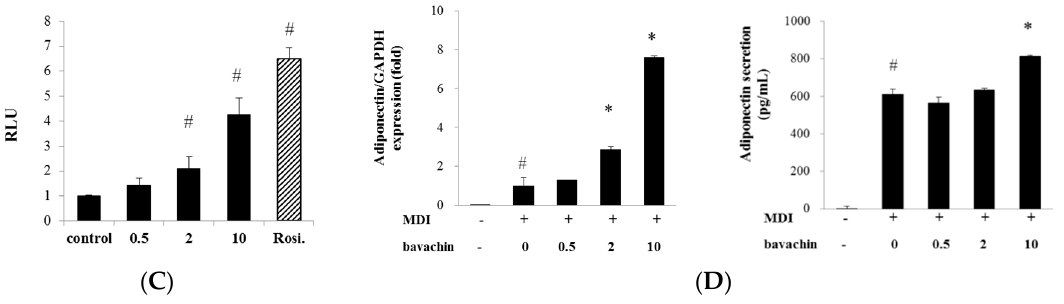
Figure 3. Effect of bavachin on the expression of adipogenic factors: ( A ) Effect of bavachin on PPAR γ and C/EBP α protein levels of differentiated adipocytes. Pre-adipocytes were differentiated with or without bavachin at indicated concentrations. Cells were harvested on differentiation Day 5 (D5) and protein extracts (30 µg) were analyzed for PPAR γ and C/EBP α expression by Western blot analysis. Actin was used as a loading control; ( B ) Effect of bavachin on the mRNA expression of PPAR γ and C/EBP α . Differentiated adipocytes were harvested and lysed on D5. Gene expression levels of PPAR γ and C/EBP α were determined by quantitative real-time polymerase chain reaction (qPCR); ( C ) Effect of bavachin on transactivation of PPAR γ . PPAR γ transactivation is presented as relative luciferase activity as described above; ( D ) Effect of bavachin on gene expression and secretion of adiponectin in differentiated adipocytes determined by real time RT-PCR and ELISA, respectively, as mentioned in the Materials and Methods. Data are expressed as mean ± SD. # p < 0.05 vs. control; * p < 0.05 vs. MDI.